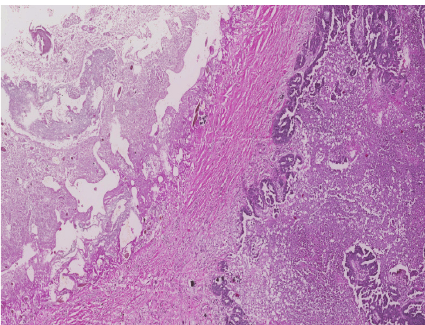
Figure 1: Left ovary: carcinosarcoma associated with the wall of a dermoid cyst with no demonstrable connection with internal cyst lining (hematoxylin and eosin,